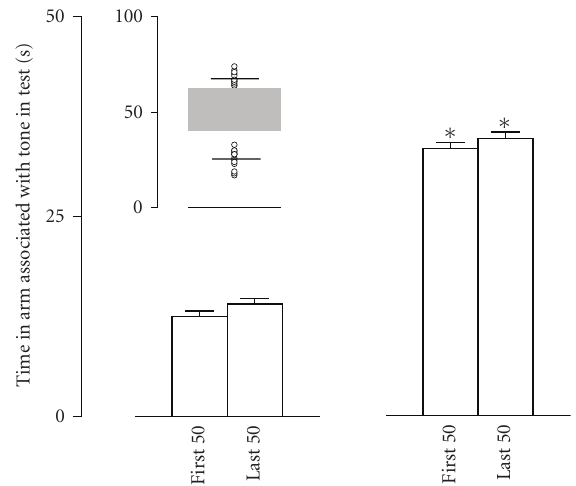
Figure 3: Induction of tinnitus by sound overexposure. The time spent in the tone arm by the conditioned rats tested in the absence of the tone, 2 weeks after the sound overexposure. Inset : raw data of WTM performance of the conditioned rats that underwent sound overexposure ( n = 26). These rats segregated into two populations, based on the criteria depicted in Figure 2(b): in one population ( n = 14), all the rats behave as if they are not experiencing the tone, while in the second ( n = 12), as if they are experiencing the tone in its ab- sence (for the grey zone, see Figure 2). Insert: the horizontal line in each group is the mean of that group; the individual data points are also displayed. Left and right panels: time spent by these two popu- lations, respectively, in the tone arm during the first and the last 50 seconds of the test ( ∗ P < .01 compared to the other subpopulation, as well as to the conditioned untreated rats tested in the absence of the